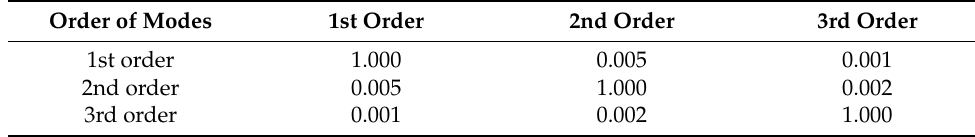
Table 4. MAC index of modal shape recognition